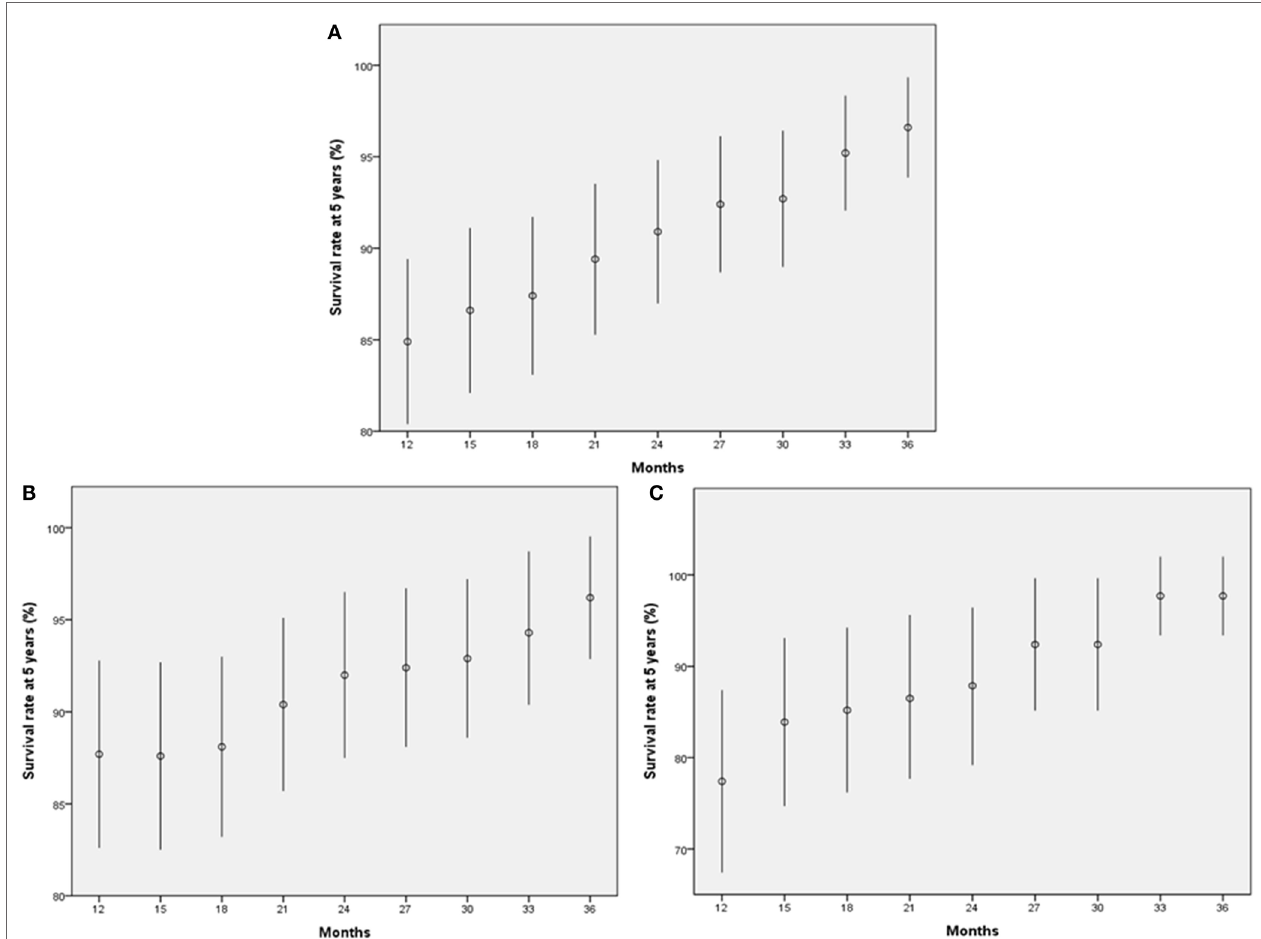
FigUre 4 | Five-year survival rates of patients who achieved each outcome . (a) All patients. (B) Patients with pT2 or less disease. (c) Patients with pT3 or greater disease. The bars indicate 95% confidence